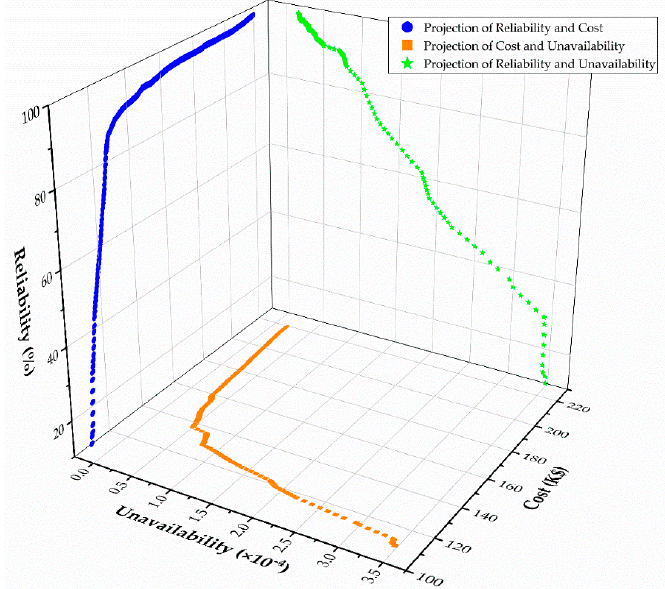
Figure 7. The relationships of three objectives (reliability, unavailability, and cost).